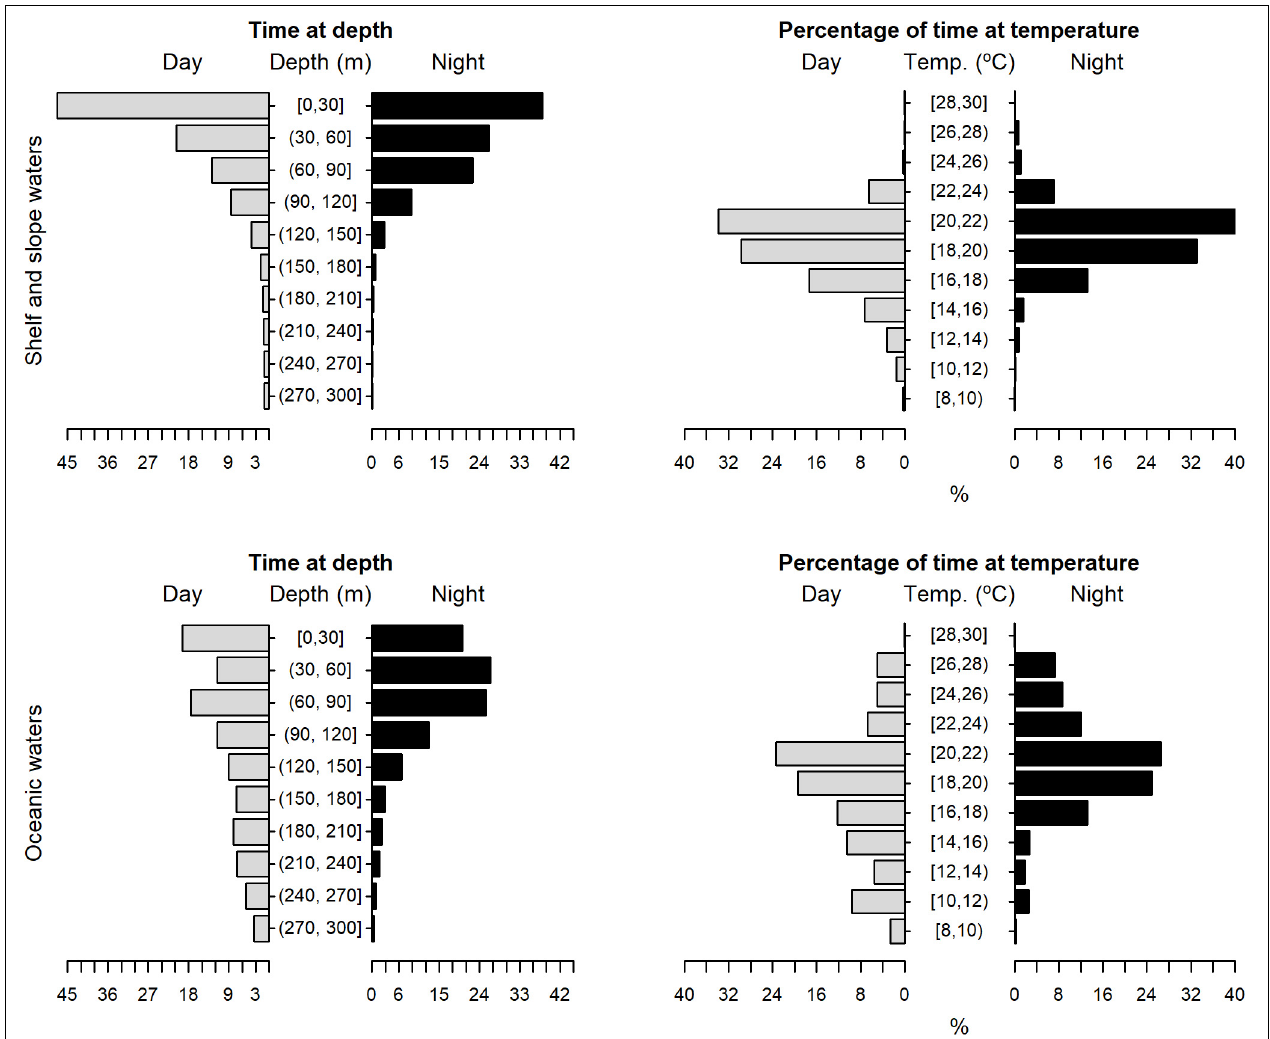
FIGURE 7 | Vertical habitat use of shortfin makos when using shelf and slope waters (top plots) vs. oceanic waters (bottom plots) , for daytime and night-time in terms of depth and temperature. Depth classes are categorized in 30 m intervals and temperature classes in 2 ◦ C